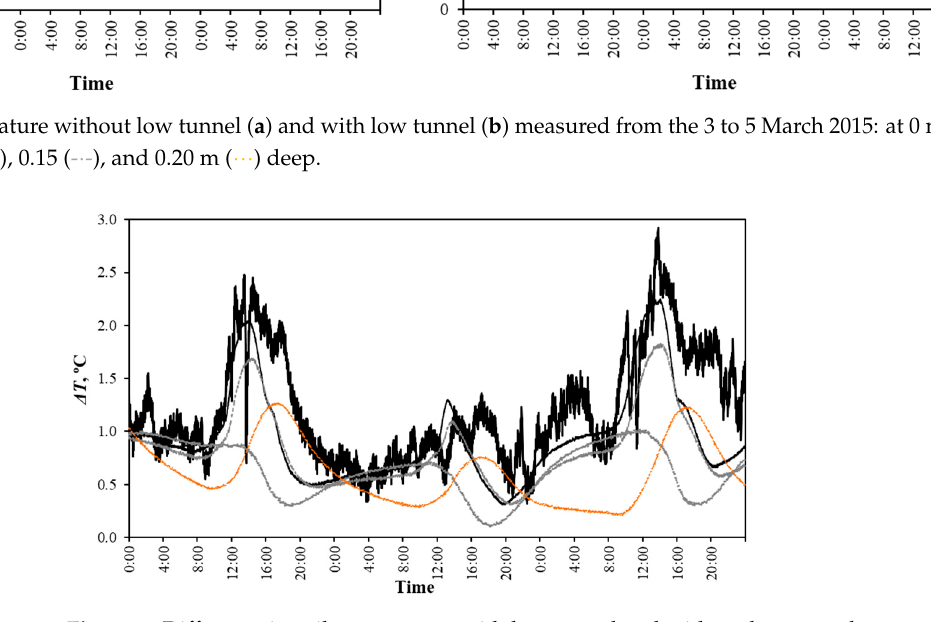
Figure 6. Soil temperature without low tunnel ( a ) and with low tunnel ( b ) measured from the 3 to 5 March 2015: at 0 m ( ▬ ), 0.05 m ( ─ ), 0.10 m (---), 0.15 (-·-), and 0.20 m ( ··· ) deep.